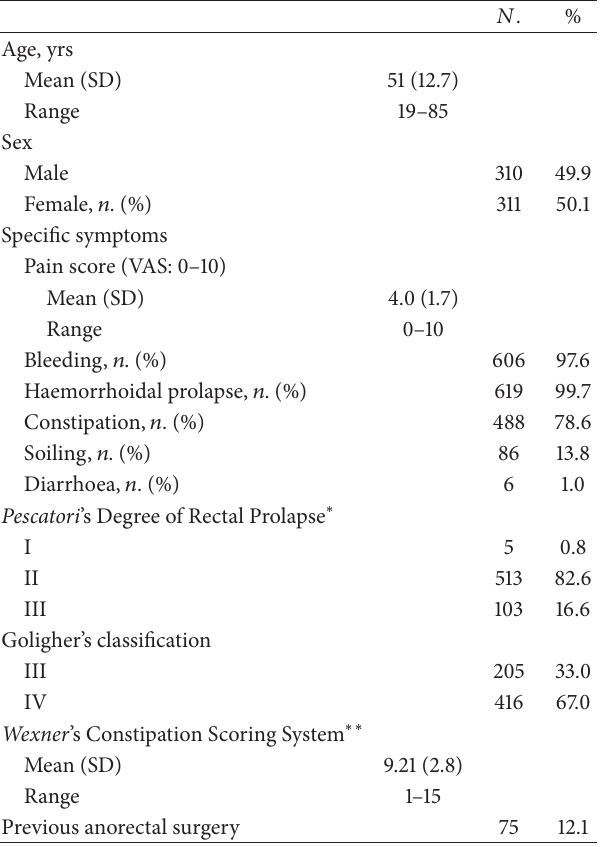
Table 1: Clinical characteristics of patients ( 𝑁 = 621 ).